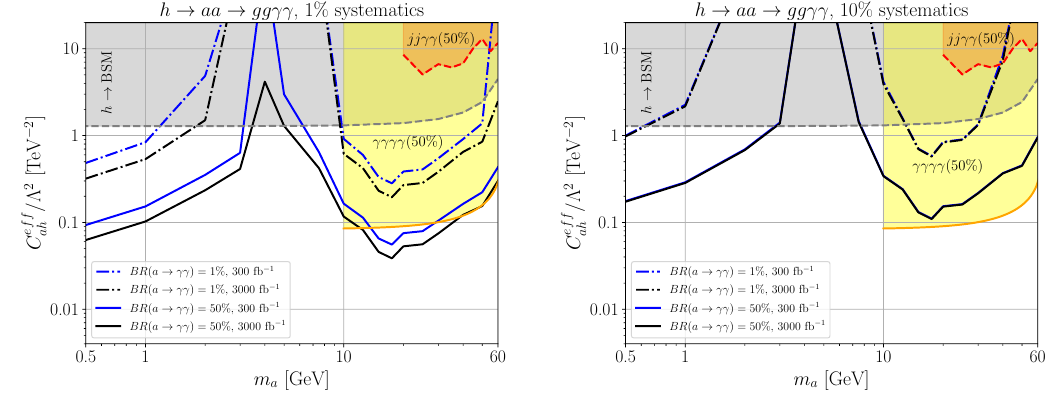
Figure 6 . The region (above the lines) in the effective ALP-Higgs coupling (in TeV − 2 ) versus the ALP mass (in GeV) where a discovery ( 5 σ ) of h → aa → j ( j )+ γ ( γ ) is possible. The orange shaded area represents the excluded region from eq. (3.3), while the yellow shaded one shows the limits from eq. (3.4), assuming BR ( a → γγ ) = 50 % in both cases. The blue(black) lines bound the 5 σ regions obtained in the j ( j ) + γ ( γ ) channel assuming 300(3000) fb − 1 of data, while the solid(dot- dashed) curves represent the case where the branching ratio of the ALP to photons is 50%(1%). We show two different systematic error scenarios: ε B = 1 , 10 %. The gray shaded region ( h → BSM) is excluded, at 95% CL, by the LHC constraint on the Higgs total width, eq.